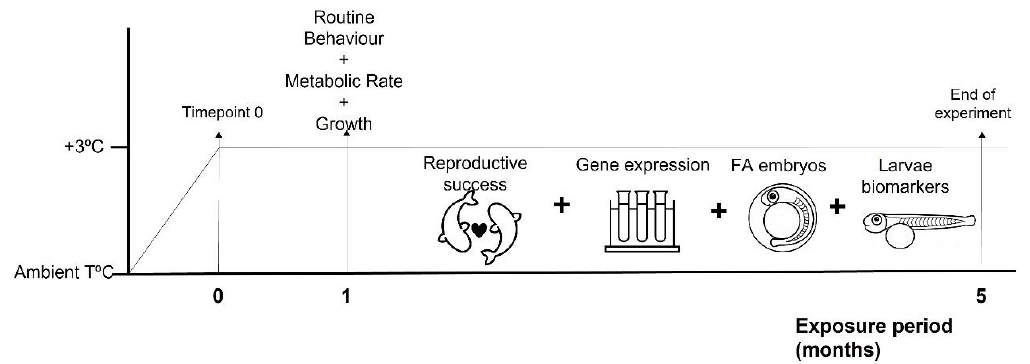
Figure 1. A diagram of the experimental design. Two-spotted goby, Pomatochistus flavescens were exposed to 4 treatments: CT + HR-control temperature and high ration; CT + LR control temperature and low ration; HT + HR high temperature (+3 ◦ C) and high ration; and HT + LR high temperature (+3 ◦ C) and low ration. At Timepoint 0, temperature in the “High” temperature treatments was reached, and the food treatments started. After 1 month of exposure to treatments, a subset of fish was tested for routine behaviour, metabolic rates and growth. Another subset of fish was exposed to treatments for a total of 5 months, which included the breeding season. During this period, reproductive success and gene expression of reproduction-related genes were determined in adult fish; fatty acid (FA) content was determined in recently fertilized eggs and biomarker analysis determined in recently hatched larvae. Fish under LR treatments did not reproduce, thus FA content and biomarkers were not